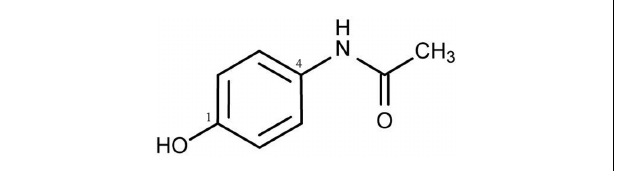
FIGURE 1 | Structure of acetaminophen ( N -Acetyl-4-aminophenol). The phenolic structure with a substituent at the para position relative to the hydroxyl group allows acetaminophen to react with reactive species and possesses antioxidant